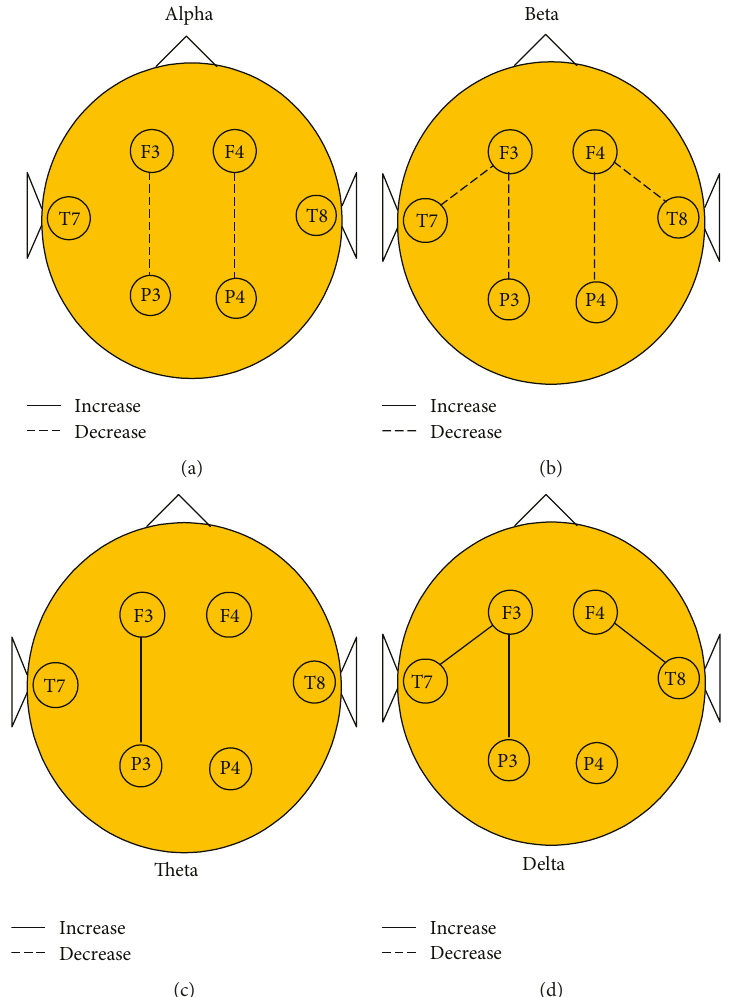
Figure 4: Functional connectivity networks during deception for the four bands (a) alpha band, (b) beta band, (c) theta band, and (c) delta band. The solid/dotted lines represent the increased/decreased connectivities between regions, respectively. The signi fi cance of all connections has been corrected by